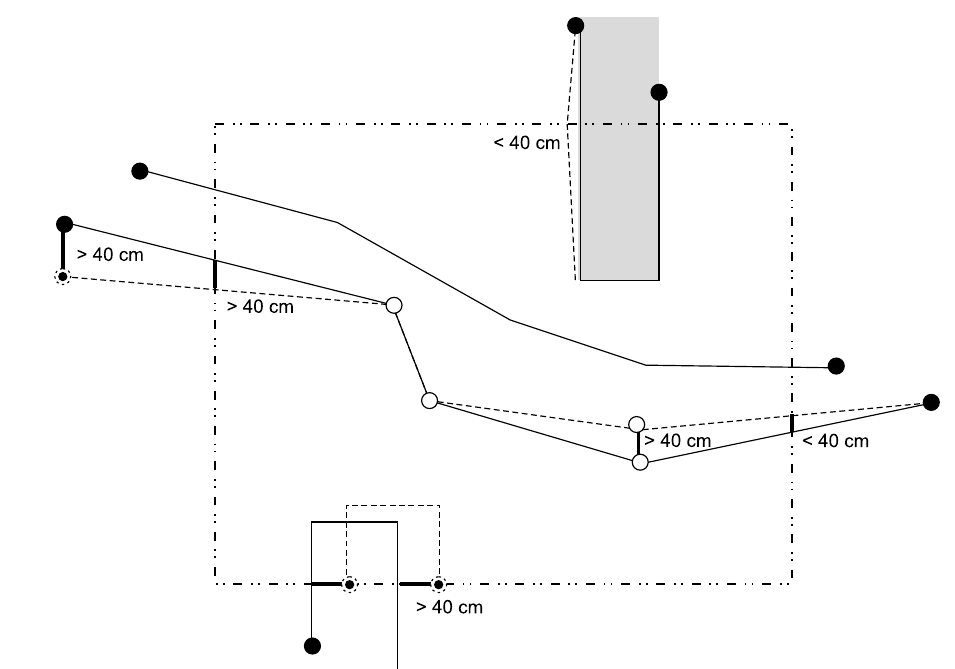
Fig. 3. Updating procedure of TIIS